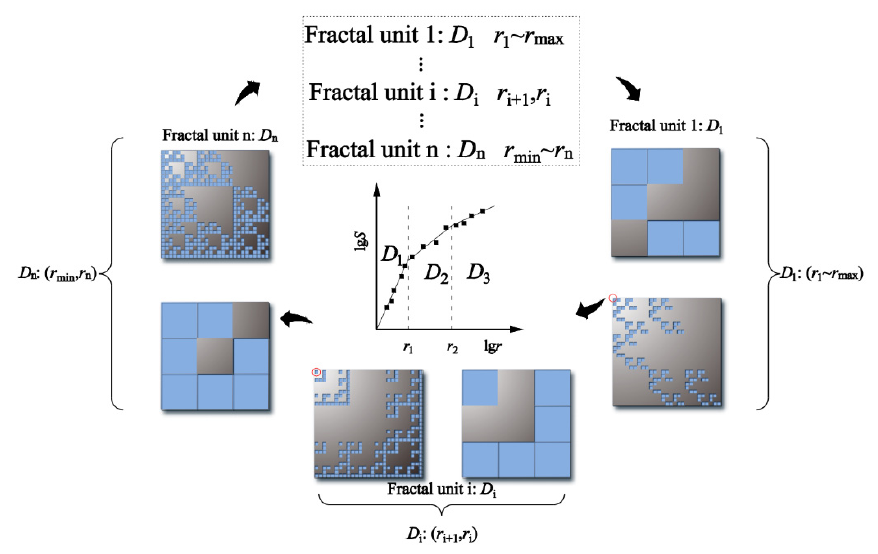
Figure 3. Schematic diagram of a MFU example.